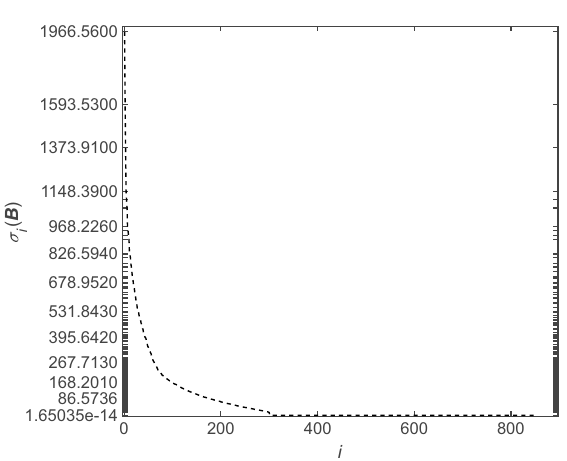
Fig. 2 Spectrum of the background error covariance matrix B .